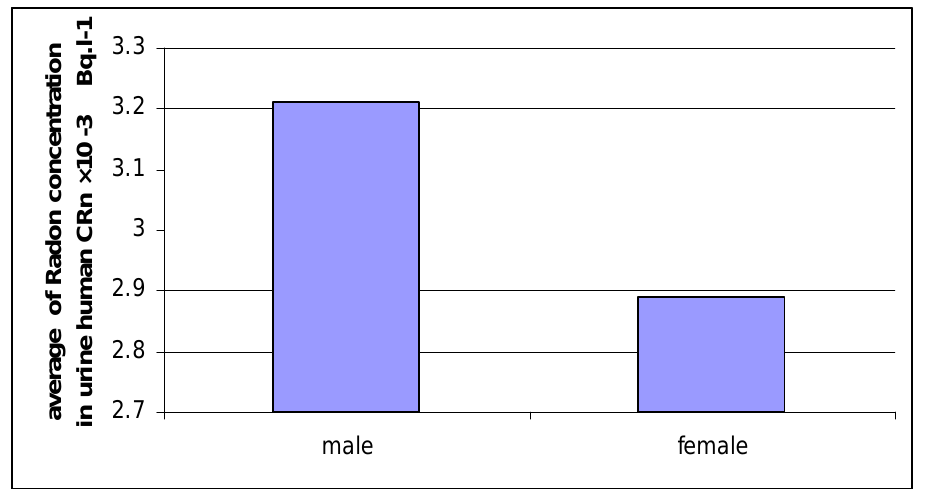
Fig.6: Average of radon concentration for male and female urine samples.